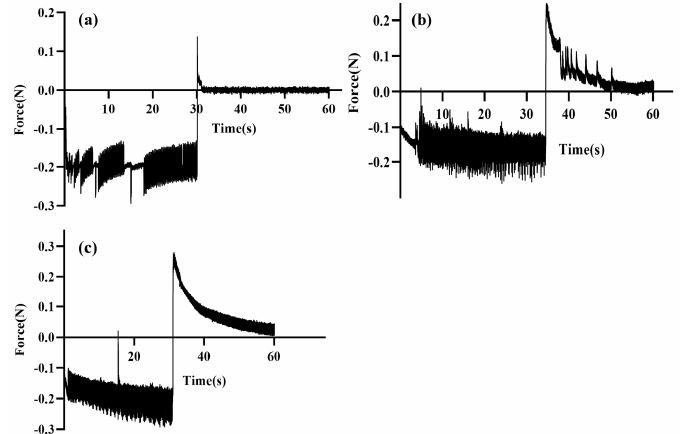
Figure 5. Mucoadhesive behaviour of ( a ) blank (P407 + P188) in situ gel, ( b ) blank κ CRG in situ gel and ( c ) blank dual ‐ responsive in situ gel, expressed in terms of mucoadhesion force (N). 3.5. In Vitro Drug Release Studies of NEB ‐ Loaded In Situ Gels In vitro drug release studies were performed in STF (pH 7.4 ± 0.5) containing Tween 80 (0.5% w/v ). The solubility of the NEB in STF was 28.62 μ g/mL. Therefore, to maintain the sink condition, 100 mL of STF containing 0.5% w/v of Tween 80 was used in the study. The mean cumulative percentage of drug released vs. time was plotted from the in vitro dissolution data (Figure 6). The NEB suspension was dissolved completely within 30 min. The NEB ‐ loaded P407 + P188 in situ gel and NEB ‐ loaded κ CRG in situ gel showed 90% drug release within 8 h and 12 h, respectively. The optimized NEB ‐ loaded dual ‐ respon ‐ sive in situ gel slowed and prolonged the drug release, with 86% drug release at the end of 24 h. This can be attributed to the interaction of κ CRG with the micelles of (P407 + P188) through secondary bonds, such as hydrogen bonds, resulting in increased viscosity of the gel formed, which is in line with the observations made from the rheological evaluation of the in situ gels. Increase in gel viscosity reduced the diffusivity of the drug through the gel matrix [23]. The drug release from the NEB ‐ loaded dual ‐ responsive in situ gel as well as the NEB ‐ loaded P407 + P188 in situ gel and NEB ‐ loaded κ CRG in situ gel followed Higuchi kinetics. The value of n in the Korsmeyer–Peppas equation for the NEB ‐ loaded dual ‐ responsive in situ gel was found to be 0.77, suggesting the release of NEB was due to the combined effect of Fickian diffusion and matrix erosion.